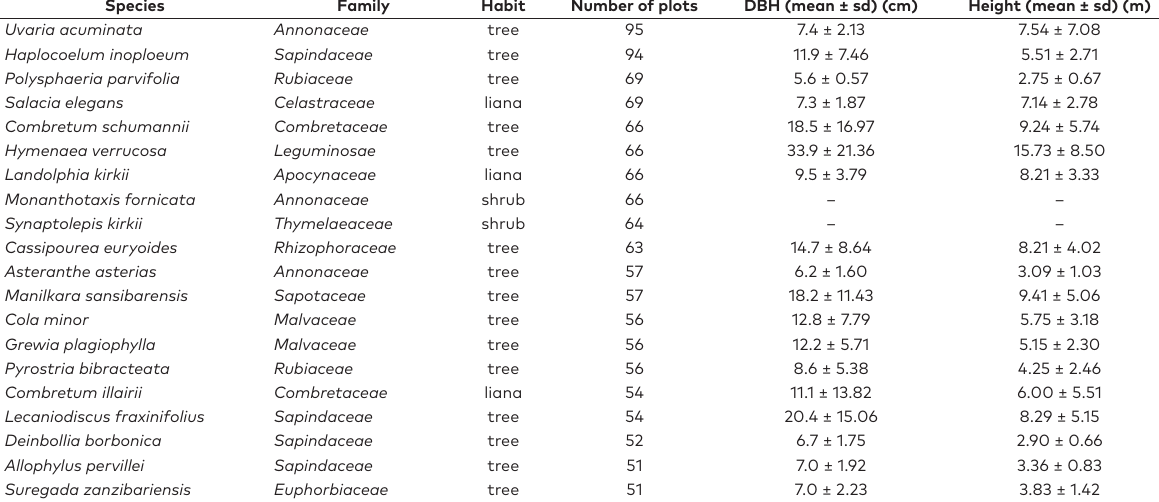
Table 3. List of the 20 most frequent species per plot (n = 158 plots), including family, habit, number of plots in which they have been recorded, and DBH and height (mean ± standard deviation) for species with DBH ≥ 5cm.